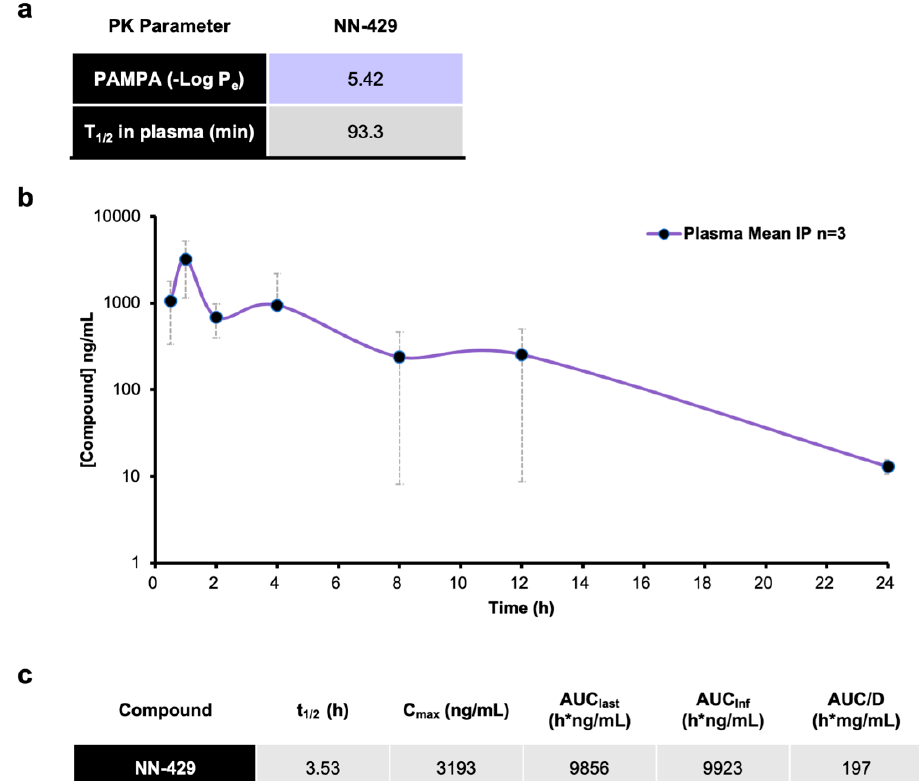
Figure 6. ( a ). PAMPA and plasma stability evaluation of NN-429. ( b ). In vivo PK profile of NN-429 (IP; 50 mg/kg), in male CD-1 mice ( n = 3). ( c ). In vivo PK parameters of NN-429 (IP; 50 mg/kg), in male CD-1 mice ( n = 3).